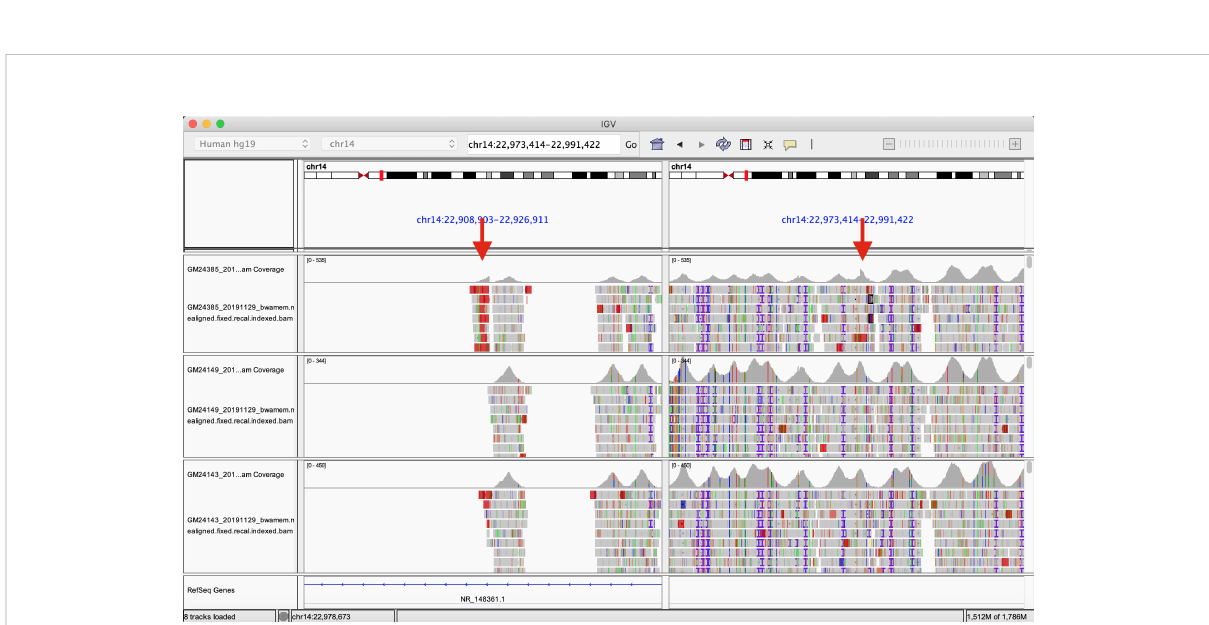
FIGURE 6 The Integrated Genomics Viewer visualization of HG002 ’ s structural variant. The Integrated Genomics Viewer visualization of the capture-based reads from HG002 (son, top), HG003 (father, middle), and HG004 (mother, bottom) aligned to GRCh37 chromosome 14. There are two red arrows indicating abrupt read-depth changes of HG002 ’ s reads at chr14:22,918,113 and